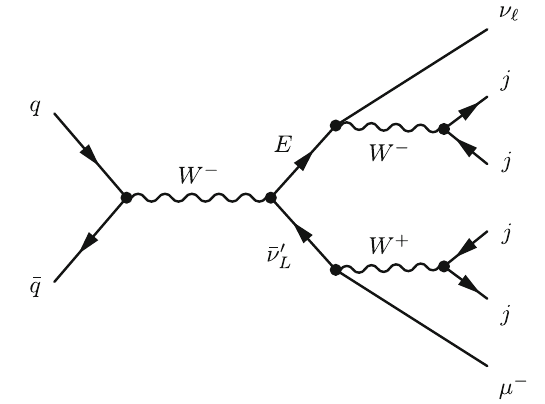
Fig. 2 Leading-order Feynman diagram for single production of the doublet VLL. Here, q and ¯ q correspond to quarks originating from the colliding protons, E represents the VLL and ν (cid:3) doublet partner. Both W (cid:3) s in the hadronic channel with j indicating first and second generation chiral